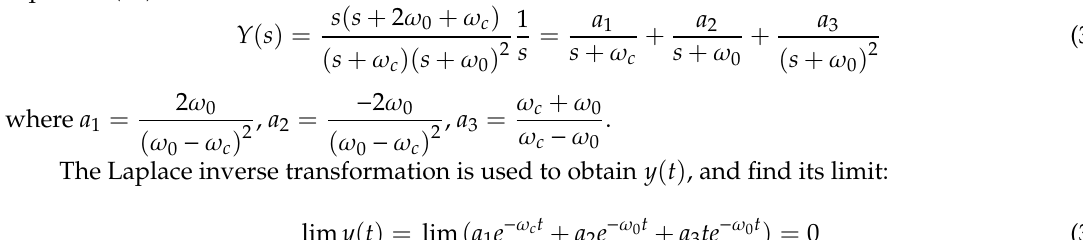
Figure 7. Angular frequency characteristic curve of disturbance rejection term ( a )